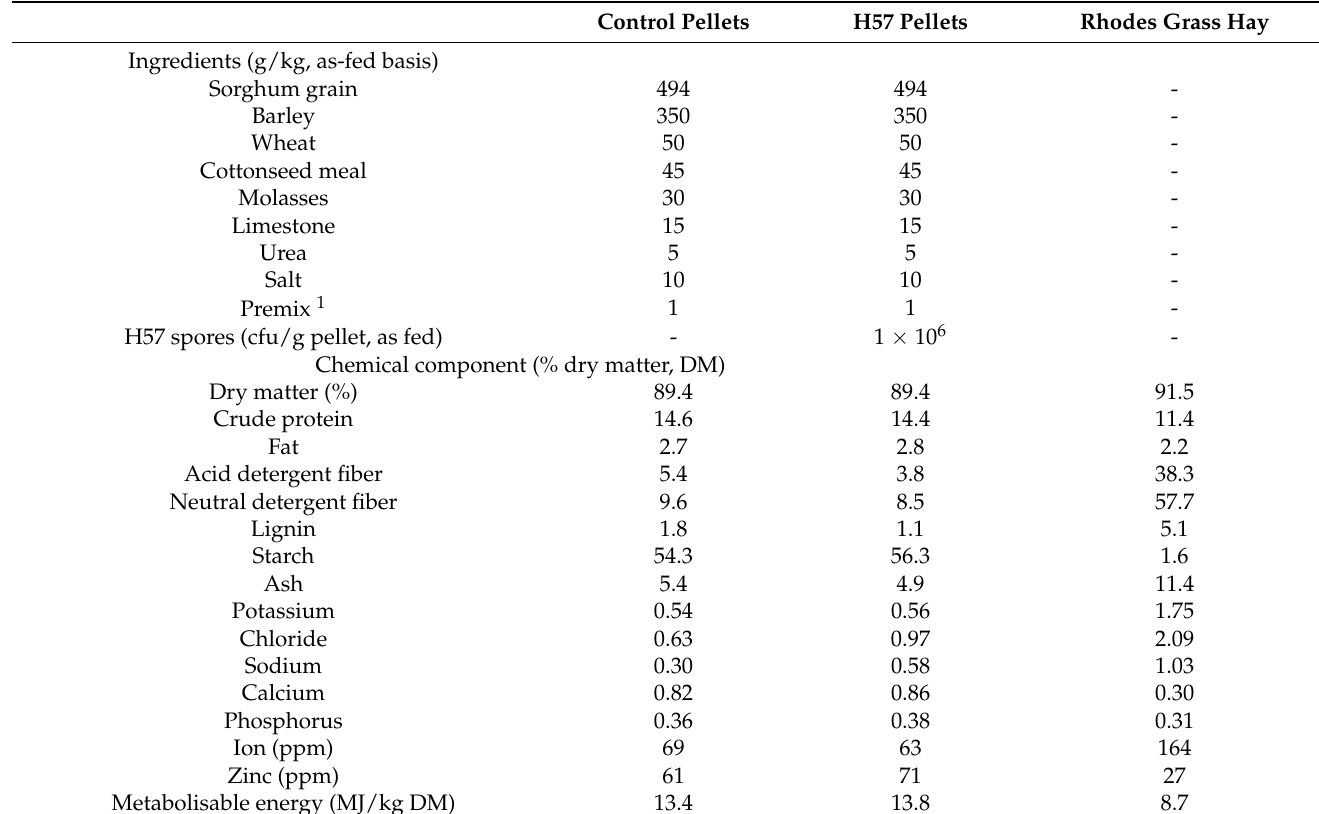
Table 1. The ingredient and chemical components of the pellets with (H57) or without (control) the H57 and Rhodes grass hay. Control Pellets H57 Pellets Rhodes Grass Hay Ingredients (g/kg, as-fed